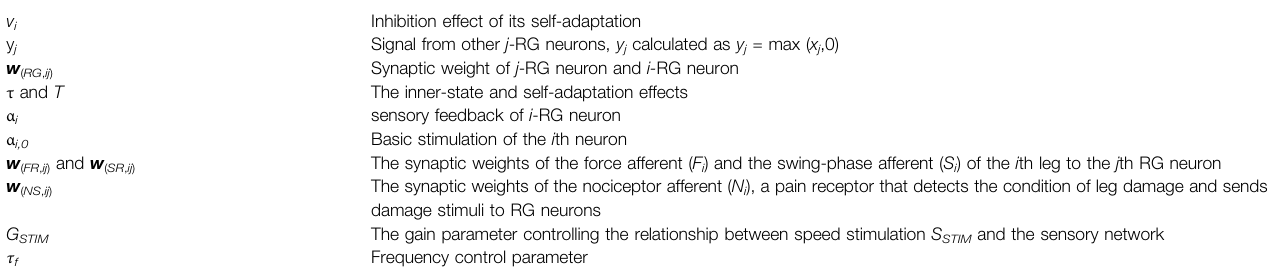
TABLE 5 | Table of parameters.